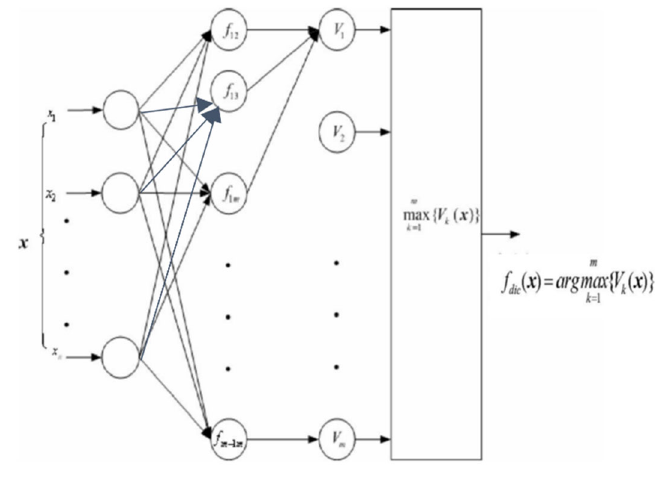
Figure 2. Structure of the FSVM at observation location.